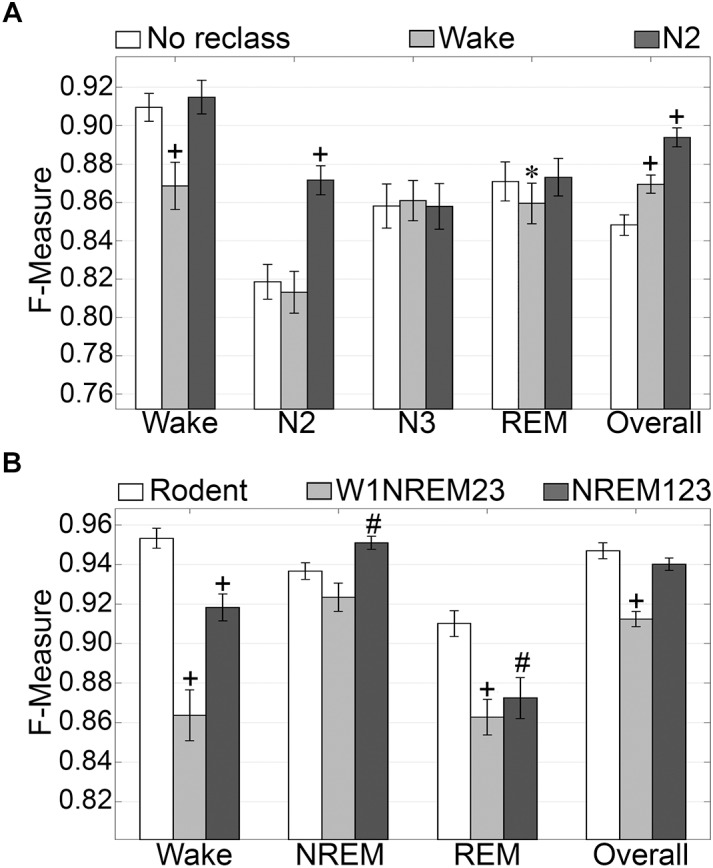
Generalization of human recordings with N1 reclassification or stage simplification versus rodent recordings. (A) Comparison of generalization performance of all human recordings (n = 52) between standard stage classification and two versions of N1 reclassification: N1 reclassified as wake; N1 reclassified as N2. Data analyzed by paired t-test compared to control (no reclassification). (B) Generalization of pooled rodent recordings (n = 54) versus human recordings (n = 52) with two versions of stage simplification: N1 reclassified as wake, N2 and N3 reclassified as NREM (W1NREM23); or N1, N2, and N3 reclassified as NREM (NREM123). Data analyzed by independent samples t-test compared to rodent recordings. Data represented as mean ± SEM. #p < 0.01; +p < 0.001.